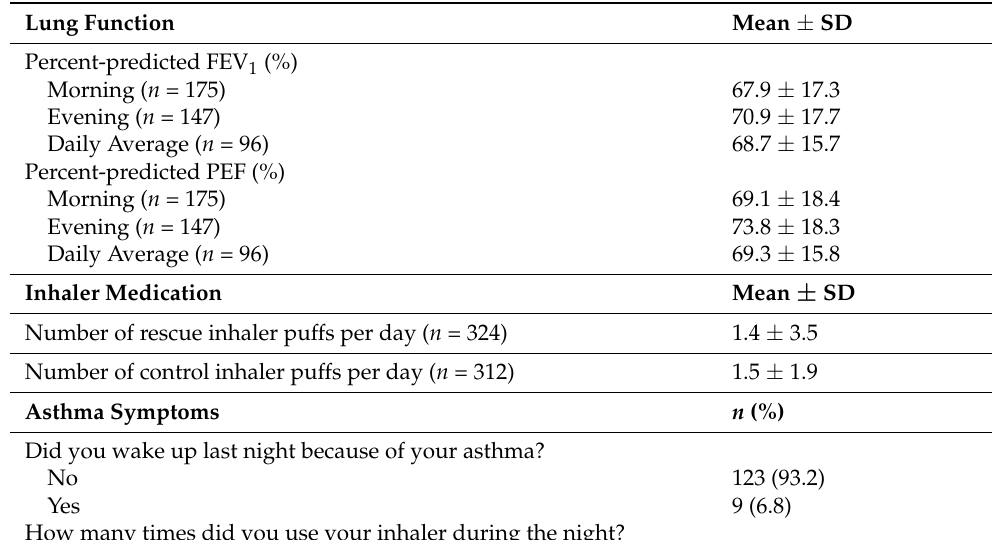
Table 2. Distributions of outcomes on the person-day level, including lung function, inhaler medica- tion use, and asthma